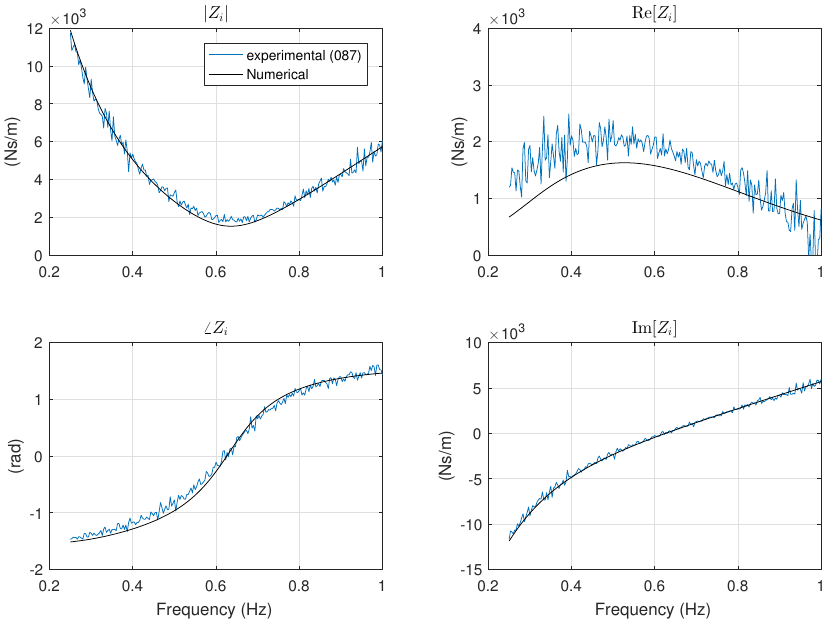
Figure 12. FRF of the intrinsic impedance Z i calculated from one experiment. The figure also shows the FRF of Z i calculated numerically using WAMIT and the physical properties of the buoy.